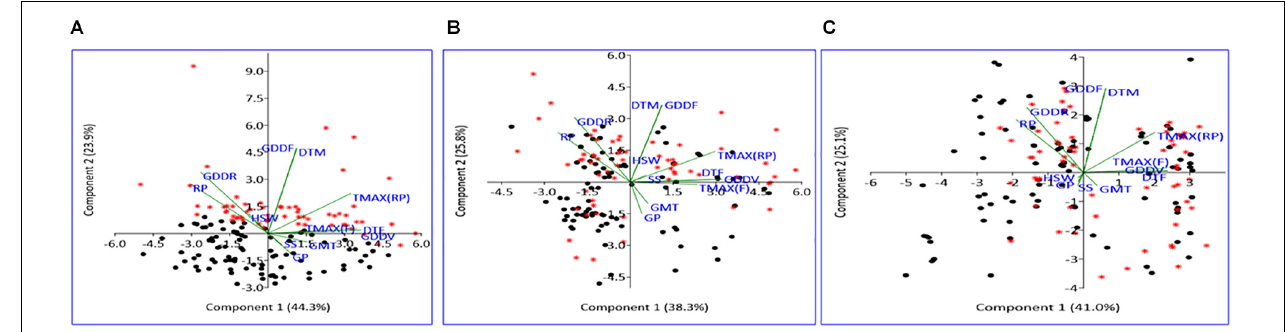
FIGURE 4 | Scatter plot of field pea genotypes on PCA coordinates under NHSE (A) , HSE-I (B) , and HSE-II (C) environments. Black dots represent early-maturing genotypes, while red asterisk represents late-maturing genotypes. RP, reproductive period; GDDR, growing degree days at reproductive period; GDDF, growing degree days of full crop season; DTM, days to maturity; TMAX(RP), maximum temperature at reproductive period; HSW, 100-seed weight; TMAX(F), maximum temperature at flowering; DTF, days to 50% flowering; GDDV, growing degree days at vegetative period; GMT, germination rate; SS, seed set; GP, germination percent; PCA, principal component